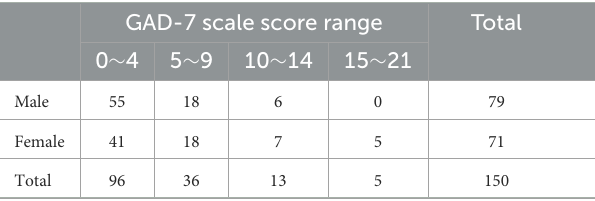
TABLE 1 Population distribution of GAD-7 scale